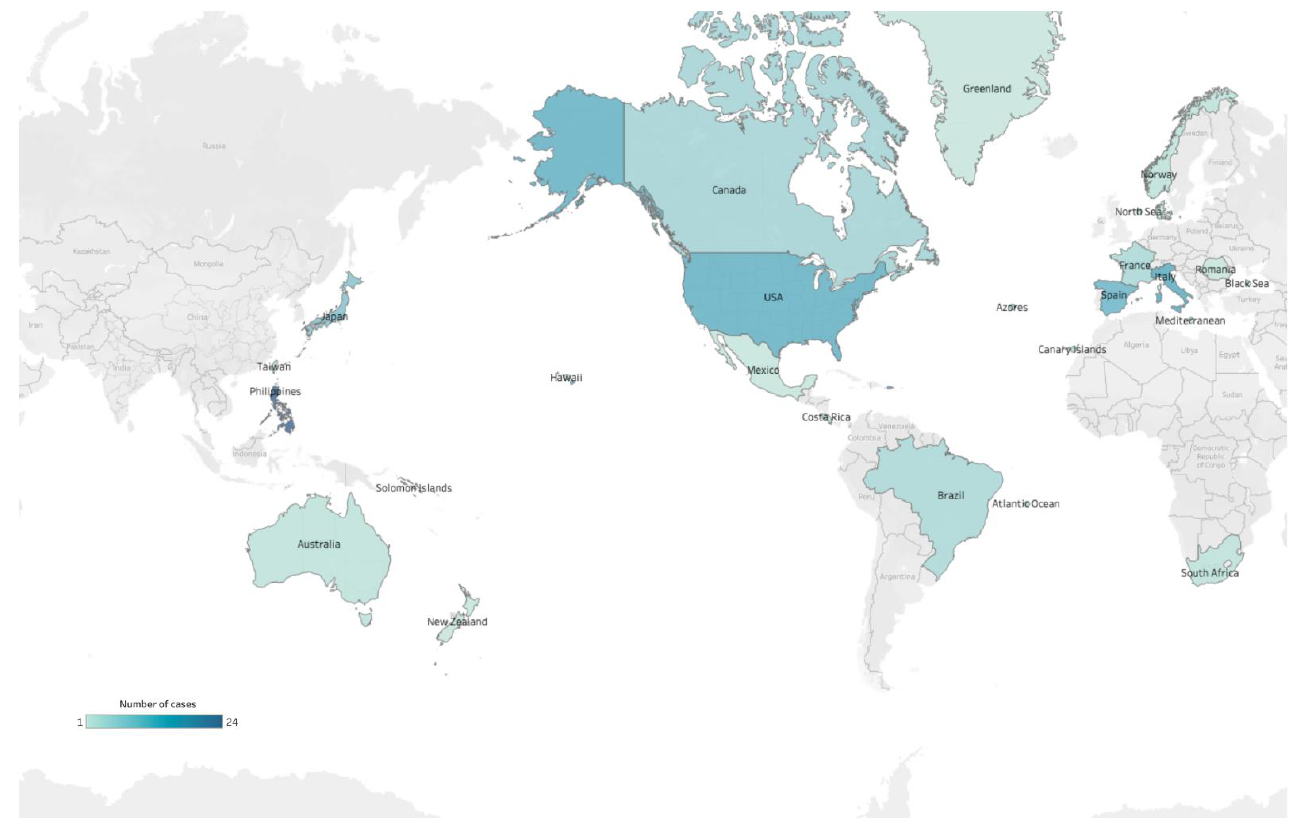
Figure 4. The world map of T. gondii or T. gondii -like protozoan parasite exposure in cetaceans.